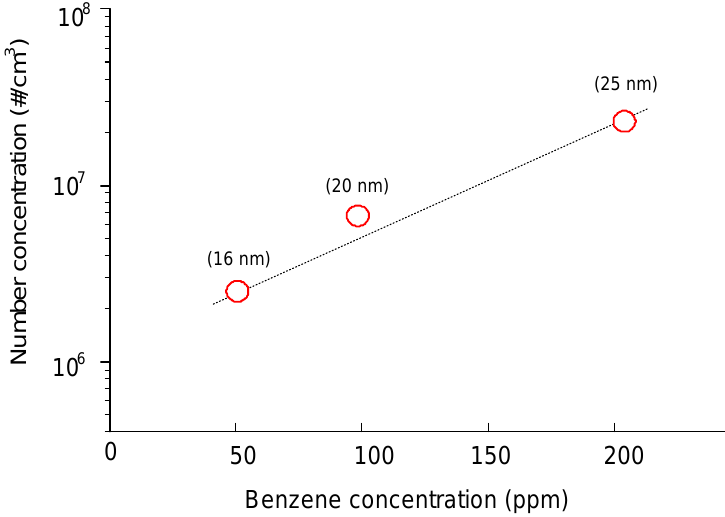
Figure 4. Influence of benzene concentration on the number concentration of aerosols (humid air). The figures in parentheses indicate the peak